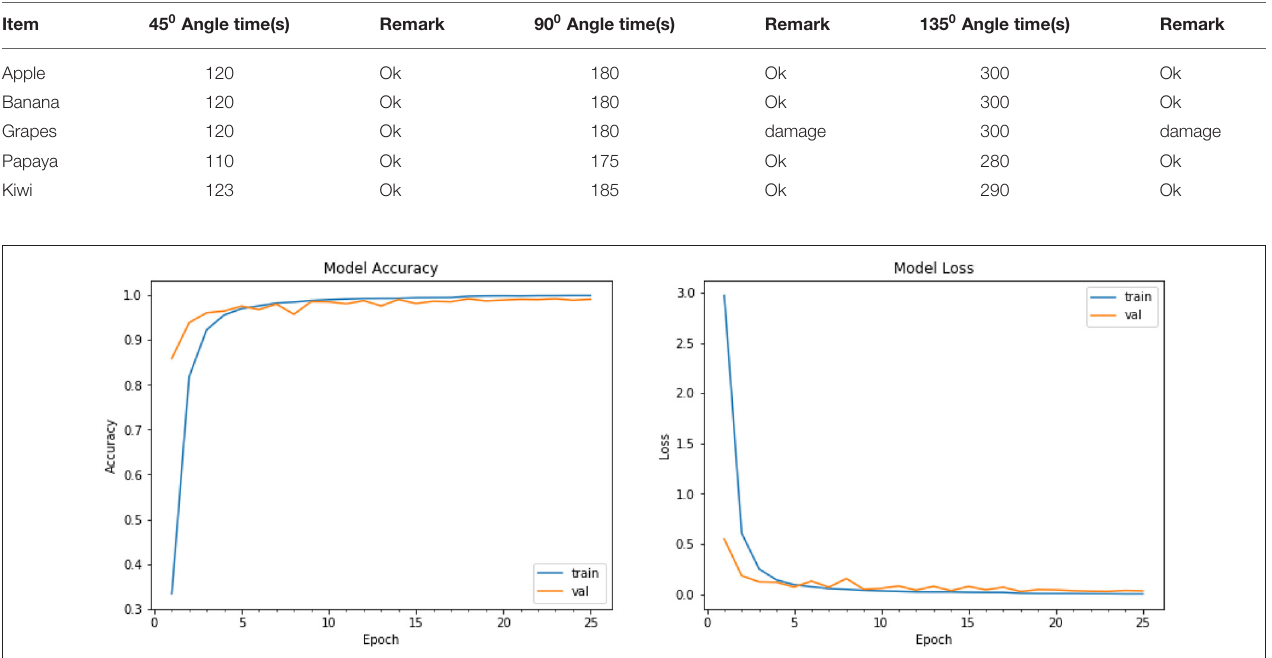
FIGURE 11 | Training accuracy vs. validation accuracy (Left) training loss vs. validation loss (Right) performance graph.